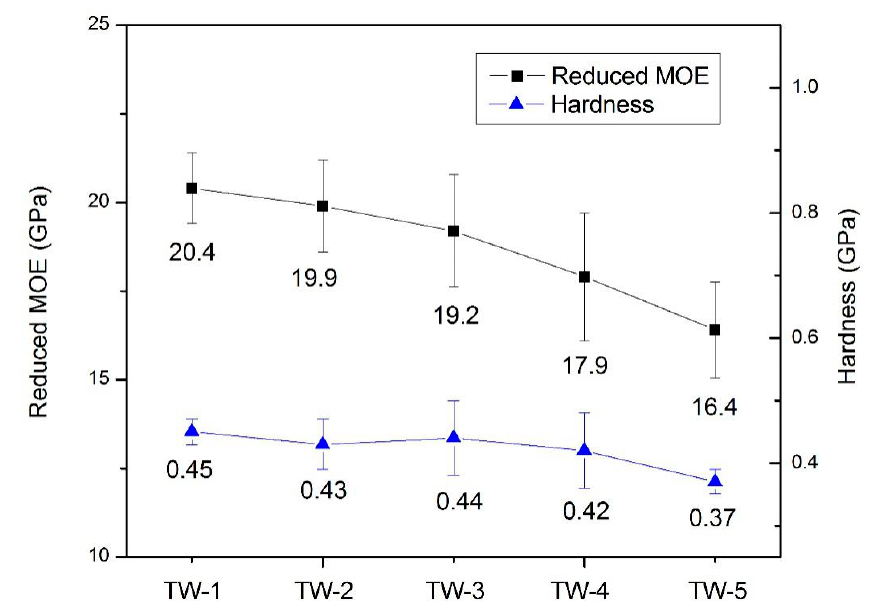
Figure 7. The reduced elastic modulus (MOE) ( E r ) and hardness ( H ) of transparent wood (TW) 303 samples. 304